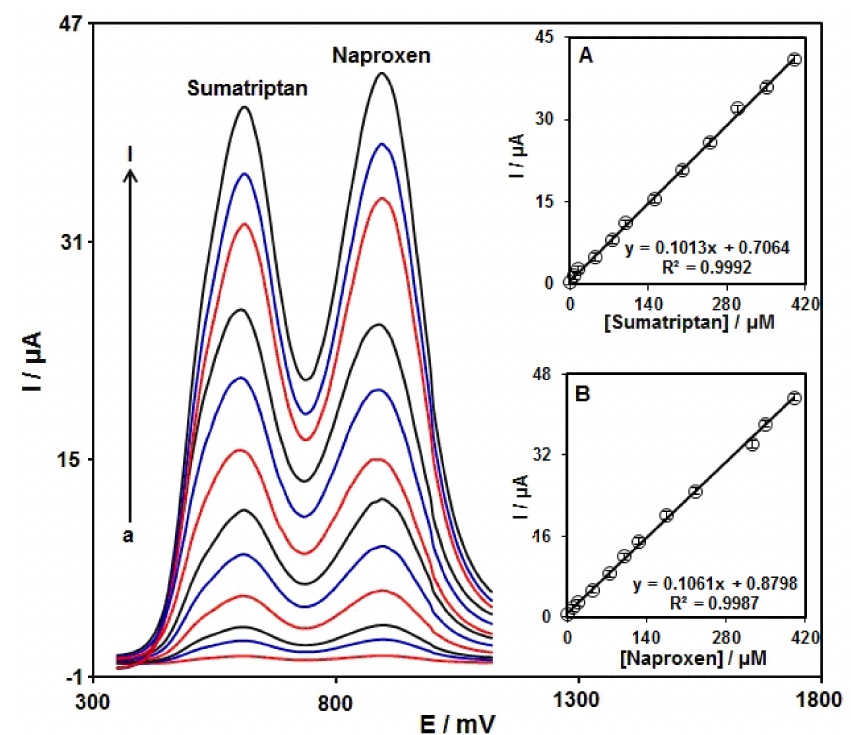
Figure 11. DPVs of Ni-Co LDH/SPE in 0.1 M PBS (pH 7.0) with various concentrations of sumatriptan (a–l: 1.0, 7.5, 15.0, 45.0, 75.0, 100.0, 150.0, 200.0, 250.0, 300.0, 350.0, and 400.0 µ M) and naproxen (a–l: 1.0, 10.0, 20.0, 45.0, 75.0, 100.0, 125.0, 175.0, 225.0, 325.0, 350.0, and 400.0 µ M). Insets: ( A ) The plot of peak current versus sumatriptan concentration, ( B ) the plot of peak current versus naproxen